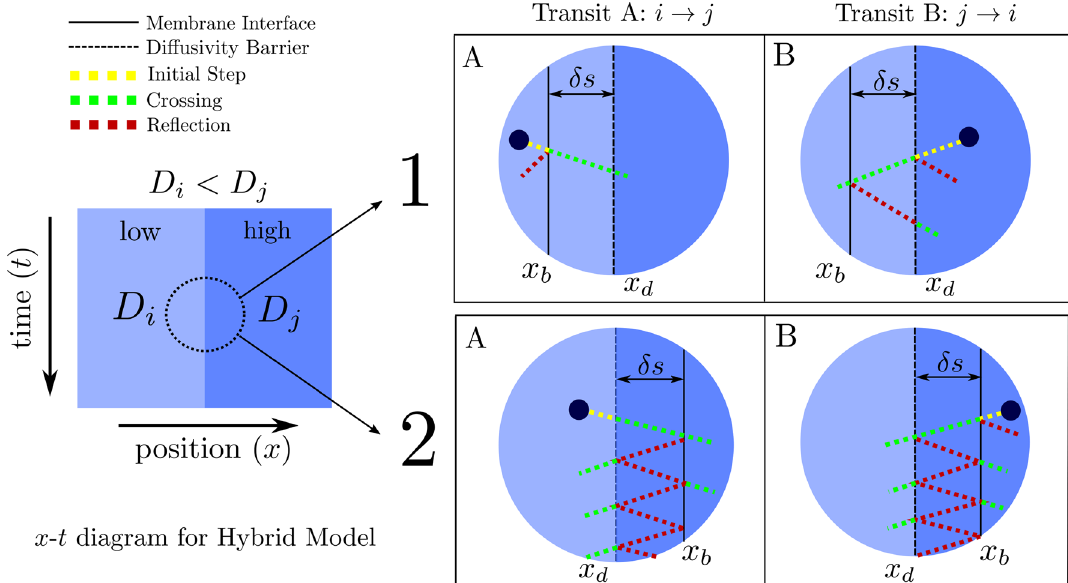
Figure 2. Illustration of the different possible sequences of events when a particle attempts a transit between compartments with low ( D i , left) and high ( D j , right) diffusivity. Configuration 1 places the membrane in the low diffusivity region ( x b < x d ), while configuration 2 places the membrane in the high diffusivity region, ( x b > x d ). We illustrate cases A and B, where A refers to an attempted transit from i Note that particles can freely cross the diffusivity interface x d from low (light blue) to high (dark blue) diffusivity regions, but may be reflected in attempting to cross from high to low diffusivity regions. For case 2, this results in multiple/infinite reflections in the infinitesimal gap δ s between the membrane and the diffusivity